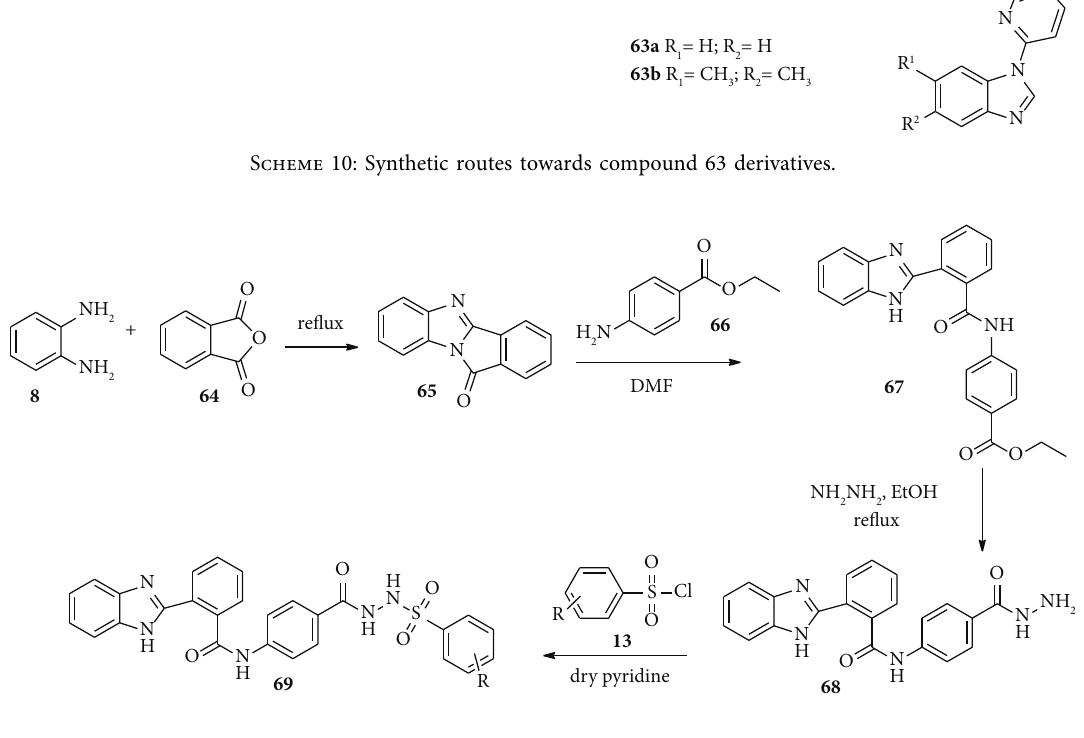
, 69f R= 4-CN; 69g R= 3